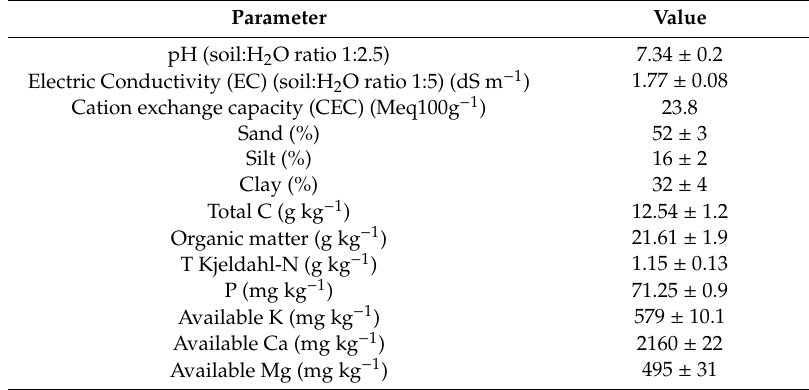
Table 1. Initial soil physico–chemical characteristics (mean ± standard error). Data are the means of three